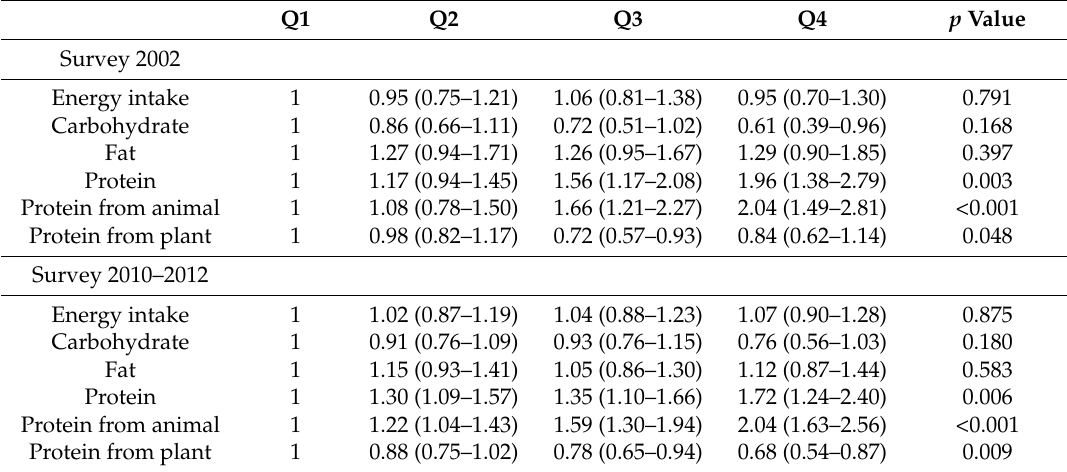
Table 6. Odds ratio (95% CI) for hypercholesterolemia by quartiles of individual macro-nutrients intake